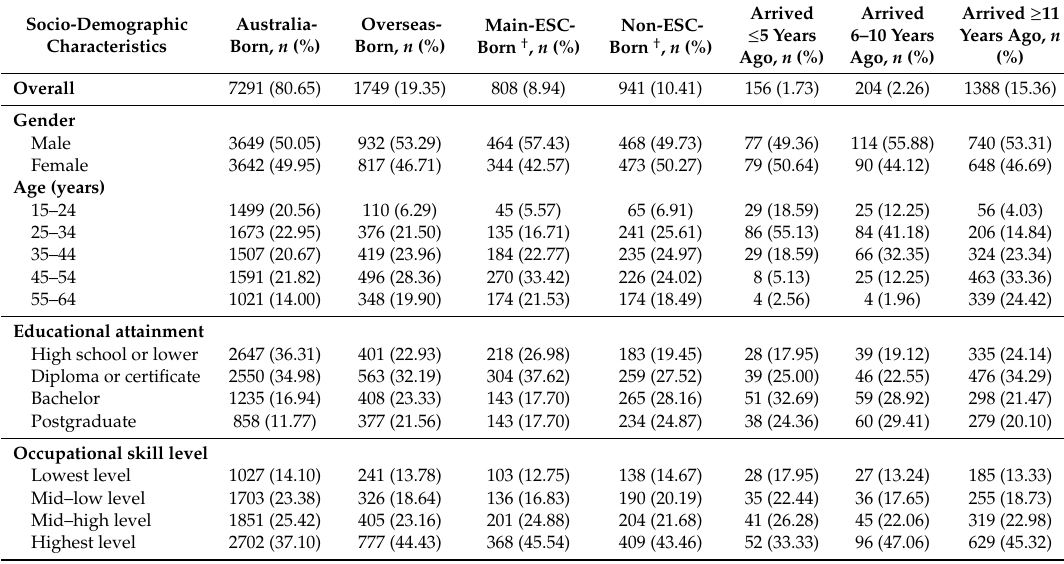
Table 1. Descriptive statistics on socio-demographic characteristics by migrant status (without weights, n =